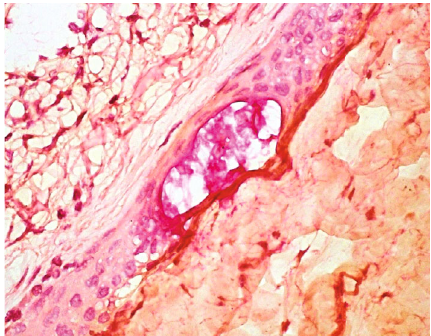
Figure 4: Mucicarmine marking mucin collection in the midst of strati fi ed squamous epithelium in a splenic epidermoid cyst (600 magni fi cation;